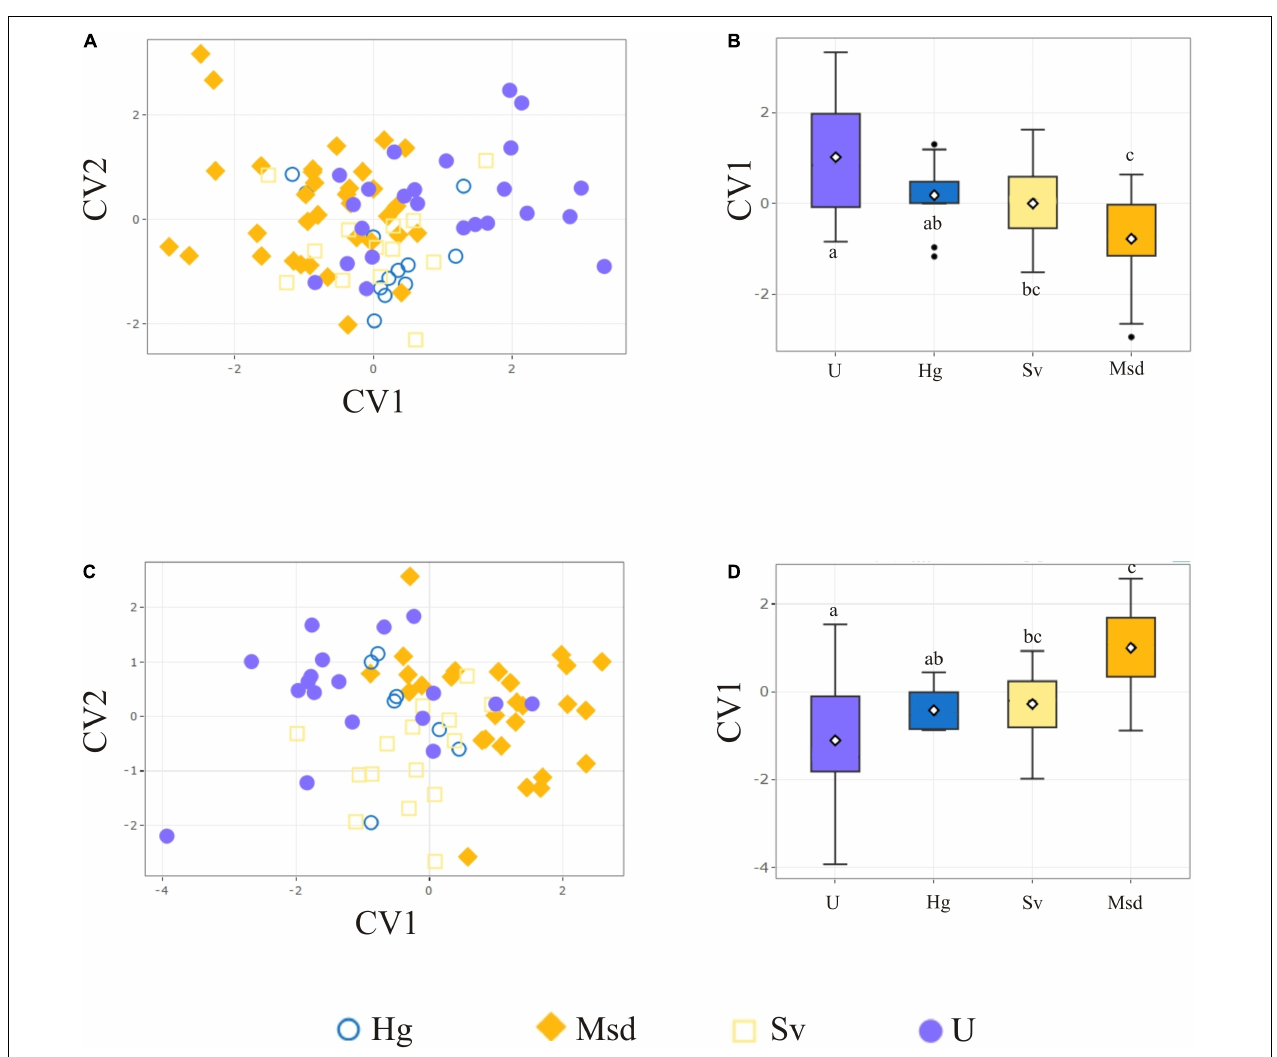
FIGURE 6 | Antennal phenotype variation of T dimidiata among landscapes by sex (A,C) . Distribution of individuals by landscape class along the first two canonical axes (B,D) . Female (A,B) and Male (C,D) . Groups with the same letter did not present significant difference ( p < 0.05) according to the Scheffé test. Urban (U), Homegarden (Hg), Secondary vegetation (Sv), and Median subdeciduous tropical forest (Msd).